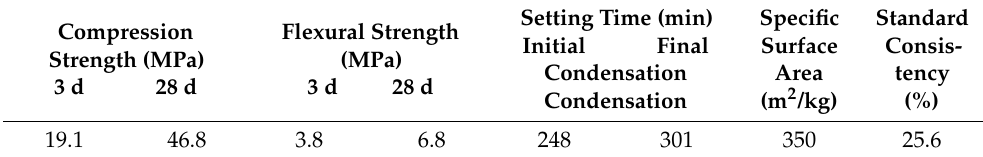
Table 1. Physical properties of